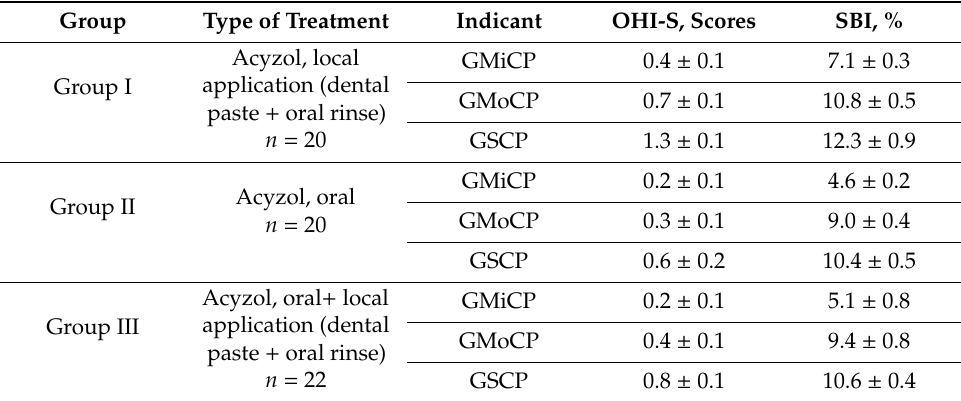
Table 4. Index score after 1 month from the start of treatment Acyzol (M ± m). Group Type of Treatment Indicant